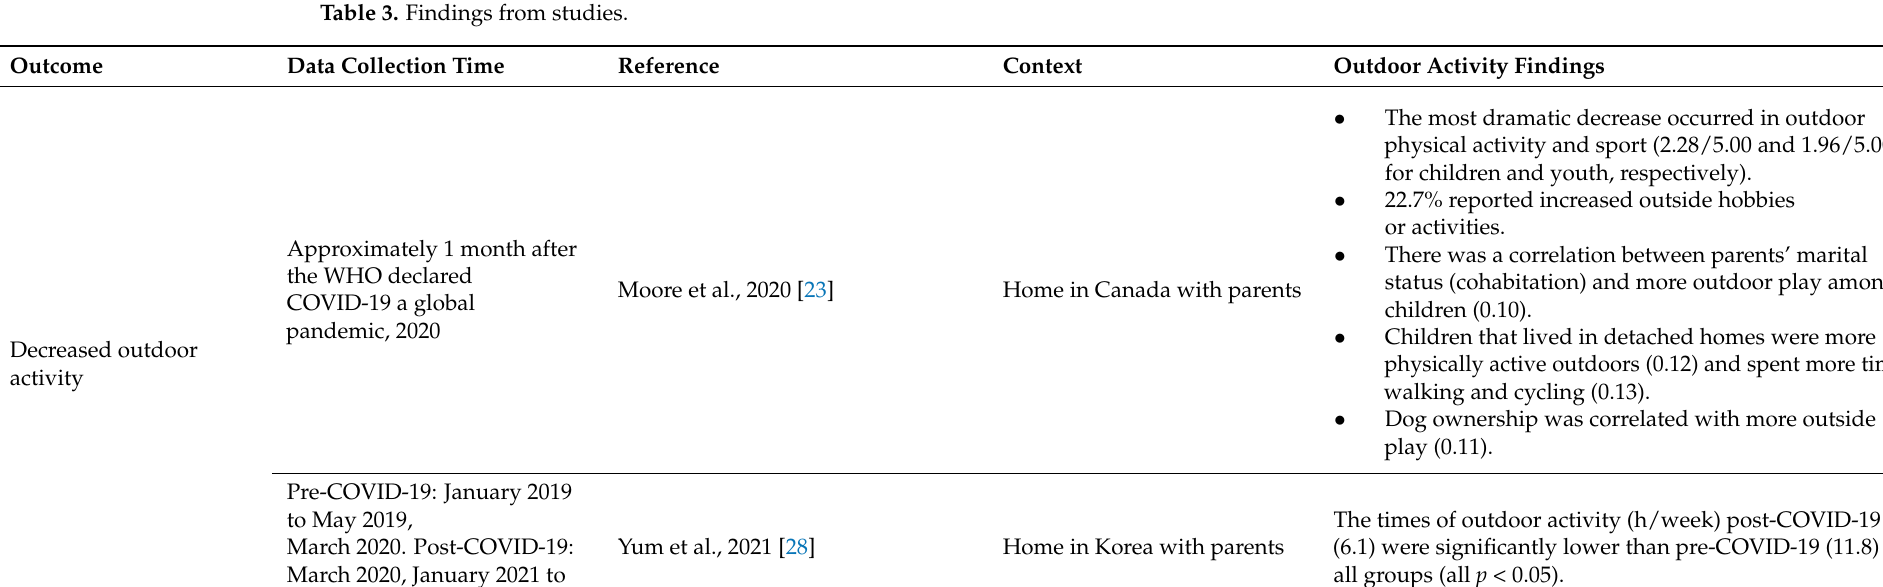
Table 3. Findings from